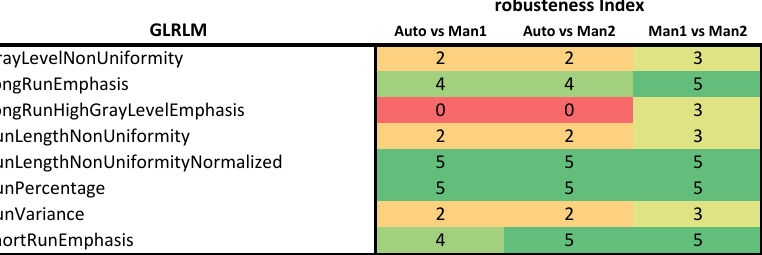
Figure 8. Robustness of the GLRLM radiomic features obtained on DCE-MRI images using automated segmentation against two manual segmentations from two independent